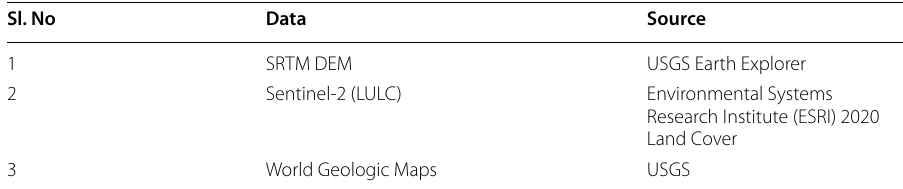
Table 1 Remote sensing data used for the current study Sl. No